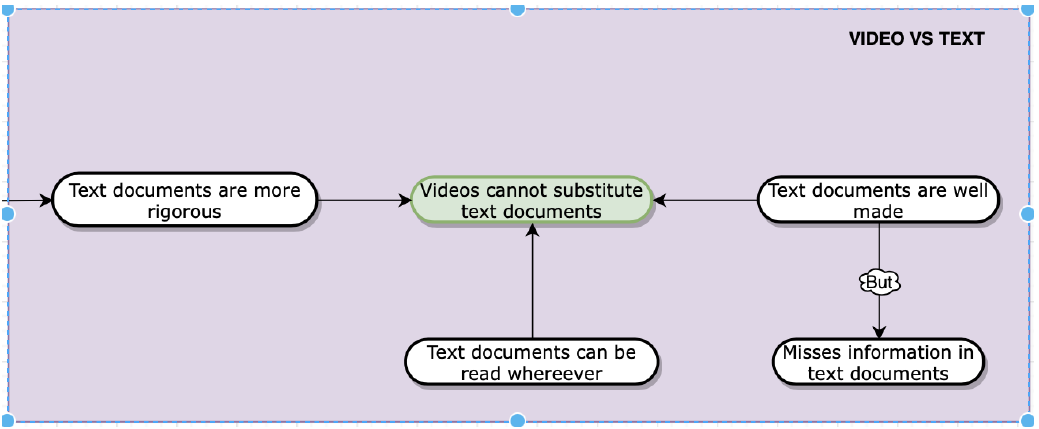
Figure 8. Enlargement of the box “ video versus text ” .